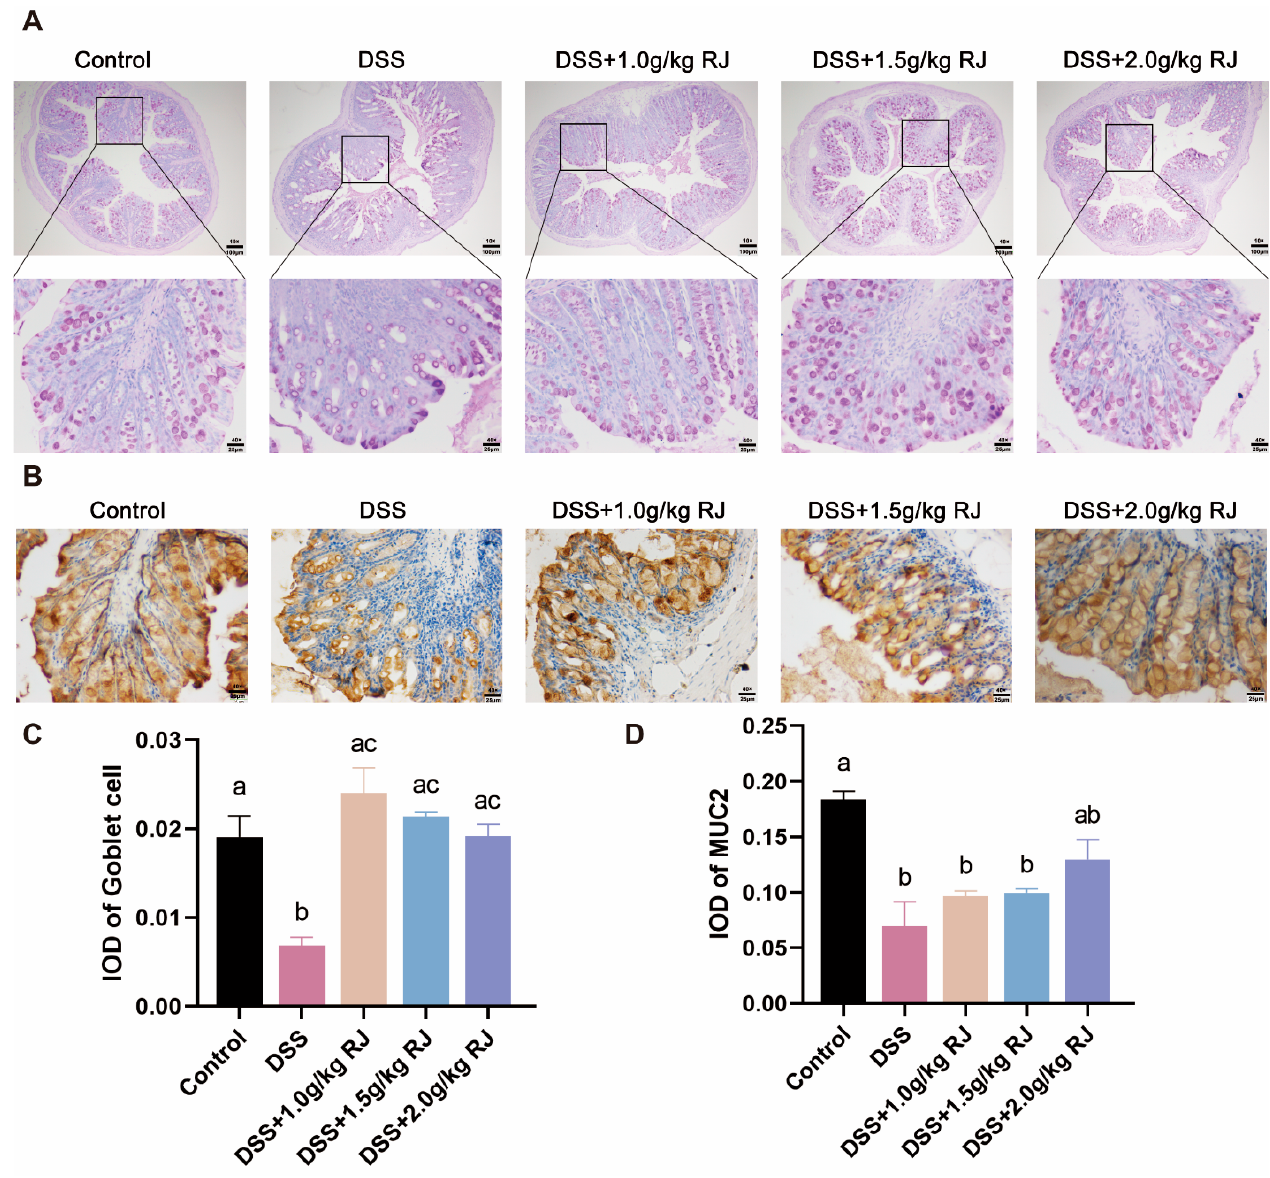
Figure 4. Oral administration of royal jelly increased the expression of goblet cells and their secretion mucin, MUC2, in the colon mucosa of mice with ulcerative colitis induced by DSS. ( A ) PAS staining of colonic goblet cells (the first line of the scale bar is 100 µ m, and the second line of the scale bar is 25 µ m). ( B ) Mucin MUC2 was stained by immunohistochemistry (the scale bar is 25 µ m). IOD was counted of goblet cell by PAS staining ( C ) ( n = 3 for DSS + 1.0 g/kg RJ group, n = 4 for other groups) and the MUC2 by immunohistochemical staining ( D ) ( n = 3). Data are expressed as mean ± standard error (SEM). The groups marked with different letters had significant differences.